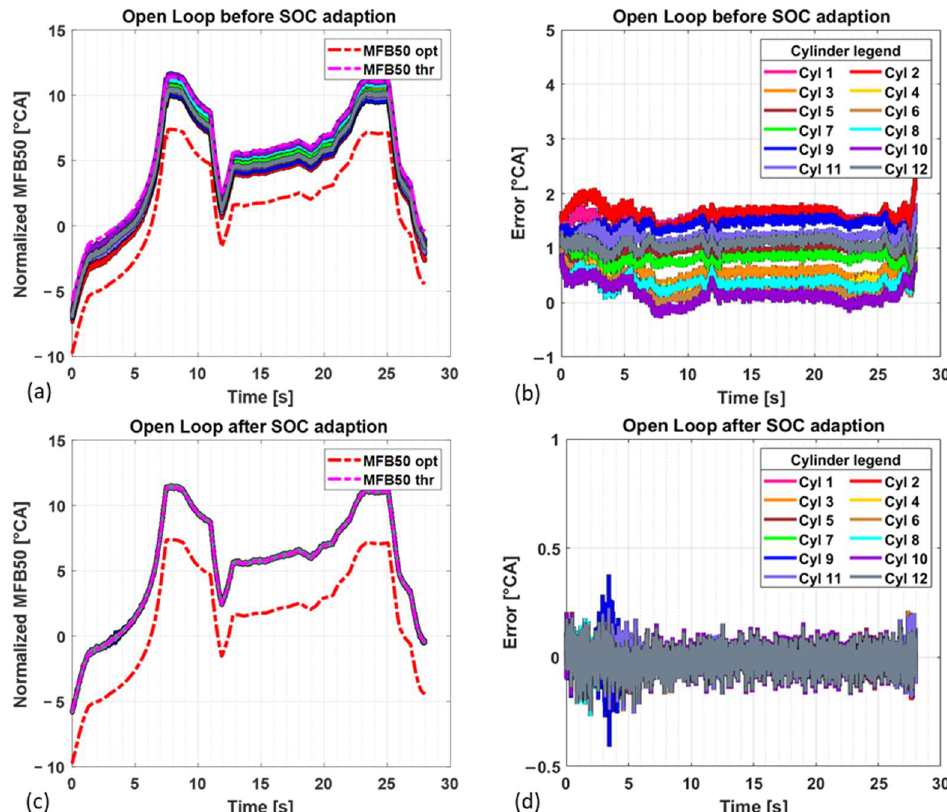
Figure 20. MFB50 comparison before and after the SOC adaptation: ( a ) MFB50 target and feedback before SOC adaptation, ( b ) error of MFB50 before SOC adaptation, ( c ) MFB50 target and feedback after SOC adaptation, ( d ) error of MFB50 after SOC adaptation.